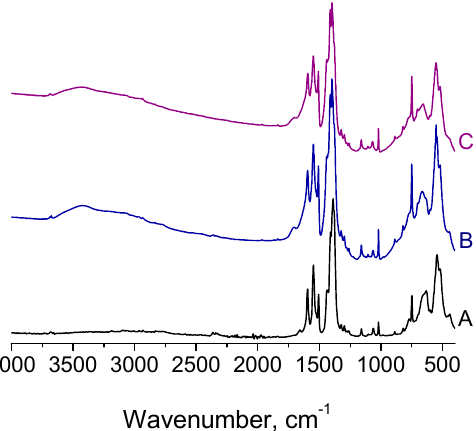
Figure 3. The FTIR spectra of ( A ) MIL-125-M, ( B ) MIL-125-L and ( C ) MIL-125-L after catalysis (reaction conditions as in Table 2, entry 10).